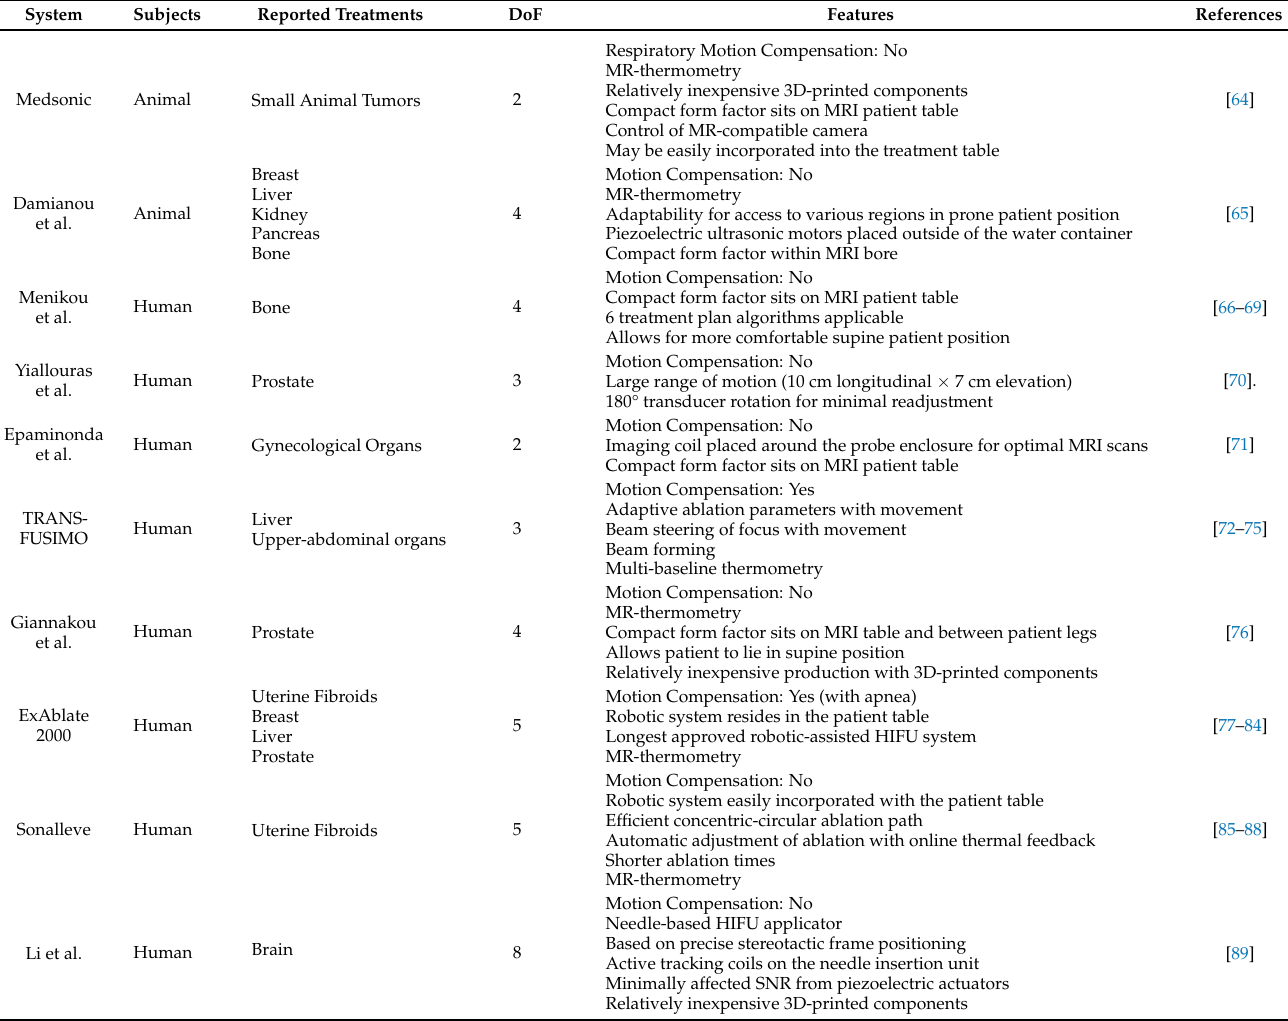
Table 2. Overview of Magnetic Resonance-Guided HIFU Systems.